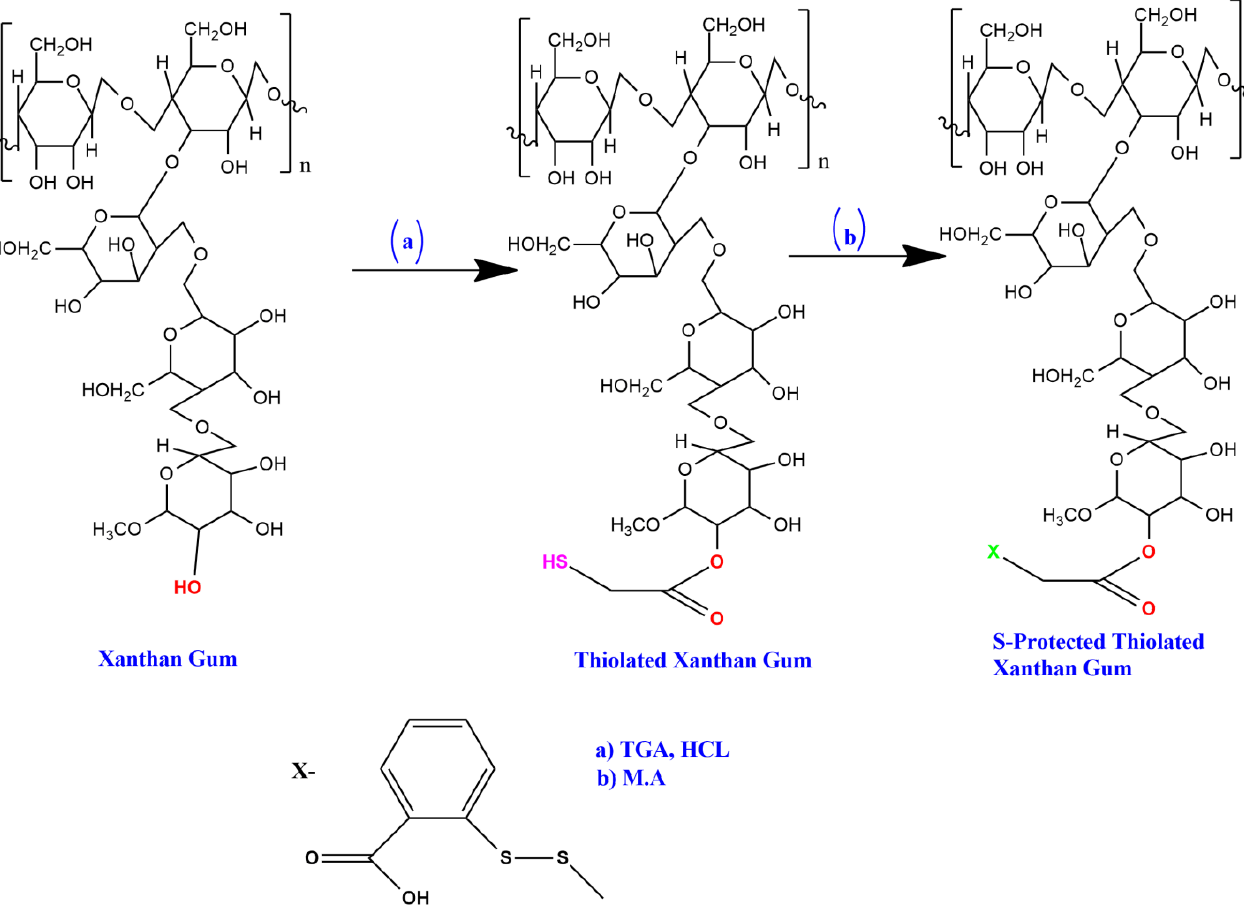
Figure 1. Schematic representation of synthesis of TXG and STX. ( a ) Synthesis of TXG using TGA and ( b ) synthesis of STX using M.A